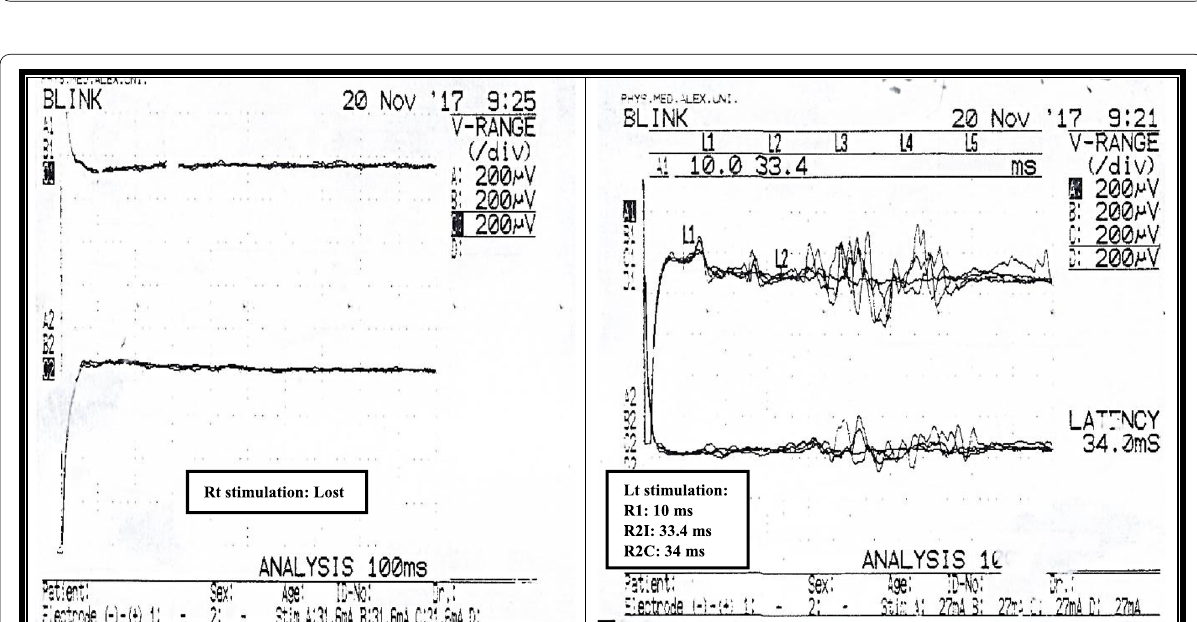
4. Delayed left R2I and absent R2C bilaterally (left trigeminal spinal complex and crossed interneuron fibers lesion) were detected in one patient.